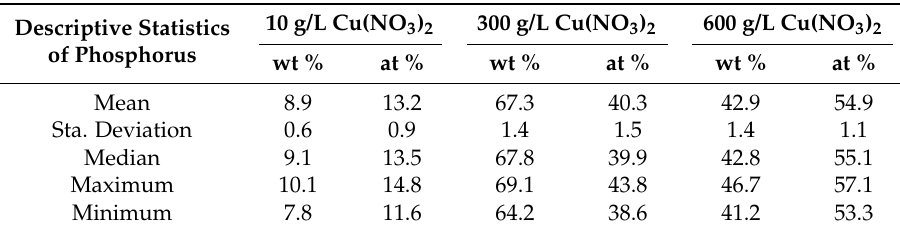
Table 2. Descriptive statistics of the amount of phosphorus in the surface layer formed on titanium after PEO.